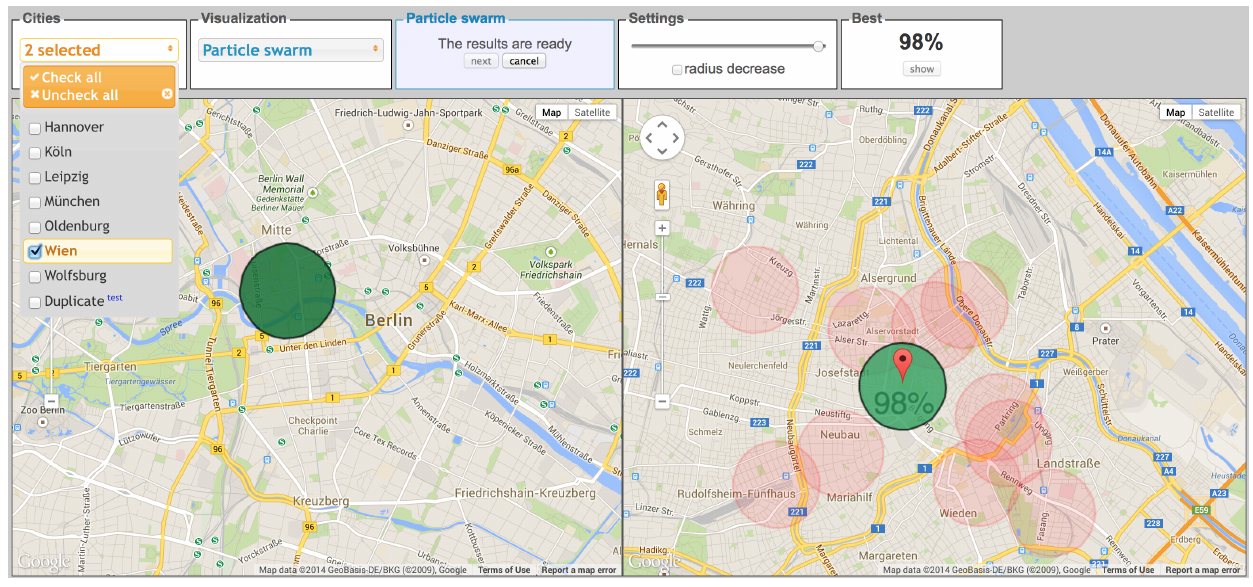
Figure 9 . PSO regional